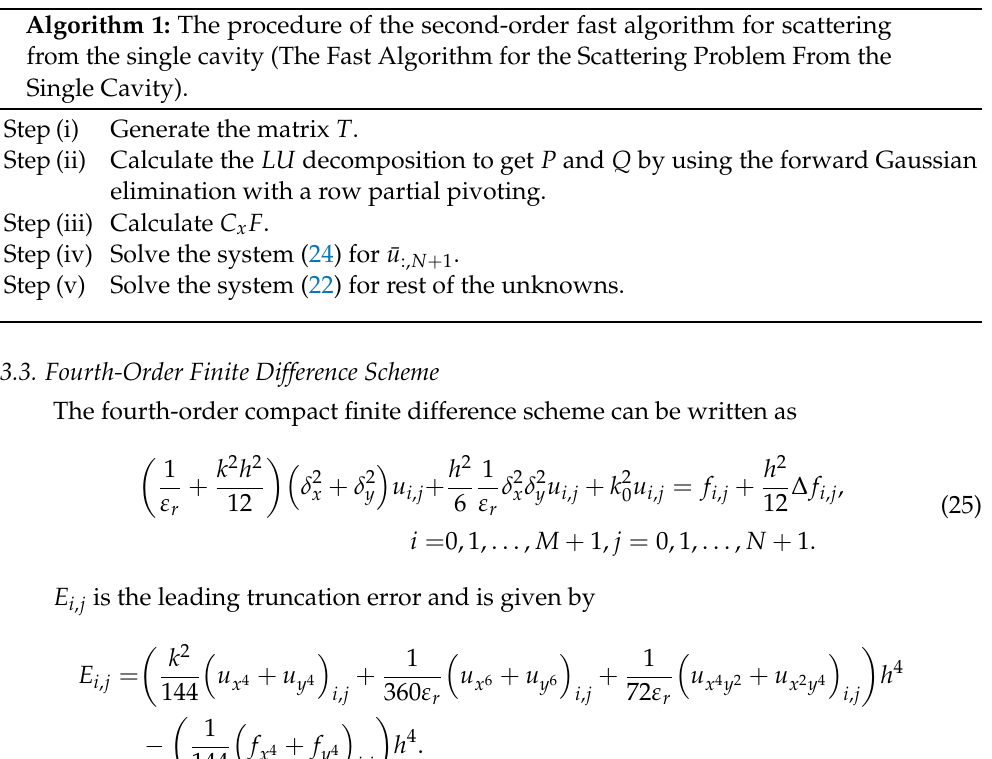
Algorithm 1: The procedure of the second-order fast algorithm for